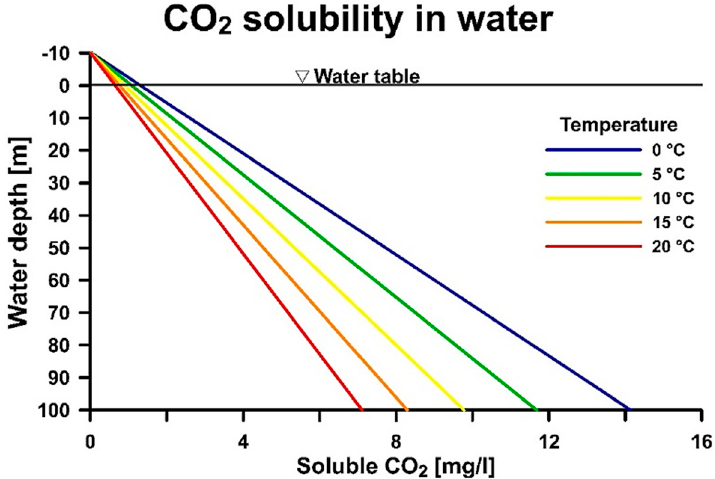
Figure 4. CO 2 solubility as a function of water depth (m) and temperature (°C). Derived from a fixed concentration of CO 2 gas of 0.039% atm p(CO 2 ) . Based on data from [27–29], found in [27].